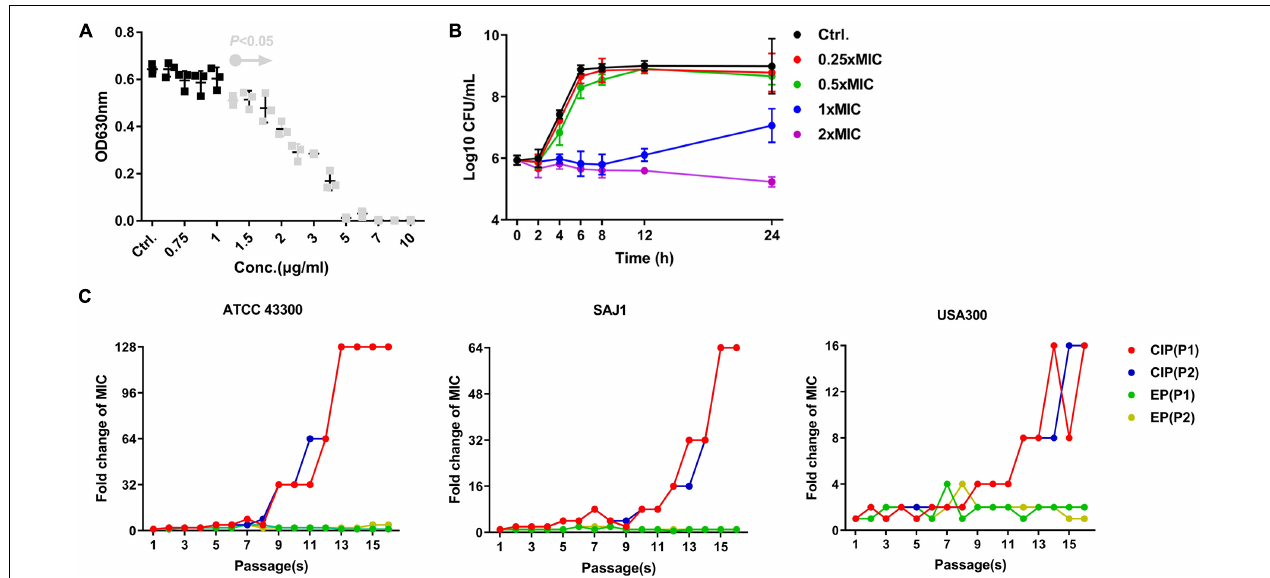
FIGURE 1 | Antimicrobial activity of EP against S. aureus . (A) Dose-dependent growth inhibition of S. aureus USA300 in the presence of varying concentrations of EP. Gray dots indicate p < 0.5. (B) Bacterial killing kinetics of EP against S. aureus USA300. (C) Occurrence of spontaneous EP- and ciprofloxacin (CIP)-resistant mutants over 15 days of serial passage in two parallel tests (P1 and P2). The MIC of EP and CIP was determined by CLSI-recommended methods. After overnight culturing, sub-MIC (1/2 × MIC) of bacterial suspension was diluted 1000-fold and used in the further antimicrobial susceptibility testing. Each line indicates a parallel